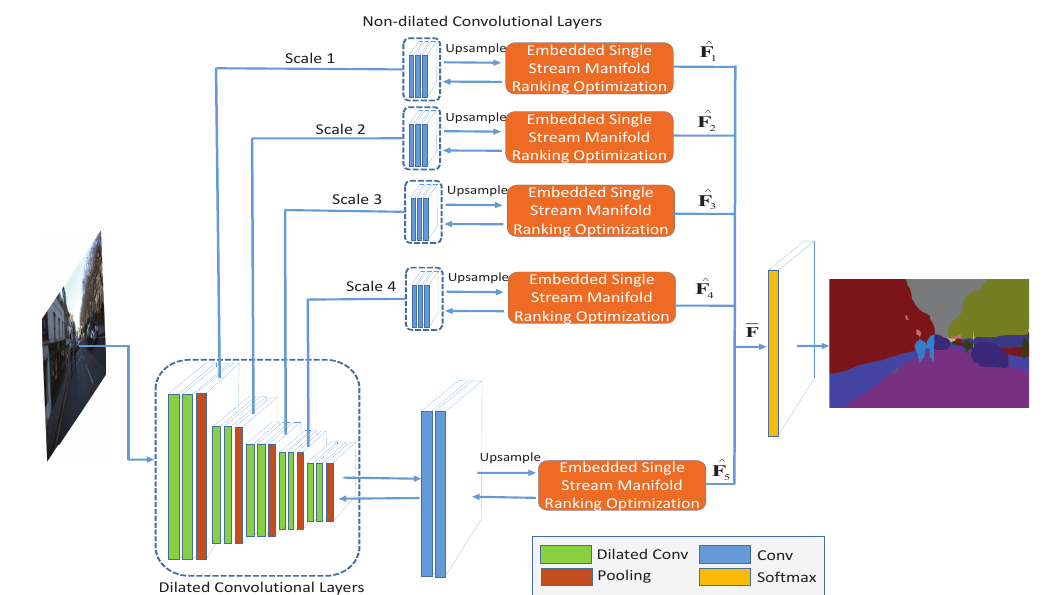
Figure 1. Dual multi-scale manifold ranking ( DMSMR ) network overview. For each dilated convolutional layer, a non-dilated convolution layer is applied following the pooling layer in each scale. The dilated and non-dilated convolution layers form a dual layer, in which the corresponding layers are optimized with the embedded feedforward single stream manifold ranking network. The scale factor is implicitly represented by the pooling layer in each block. Figure 2 illustrates how to embed the manifold ranking optimization method into the single stream network (marked with orange color in this figure). The optimized outputs of each scale, that is, (cid:98) F l generated in each scale, are combined by Equation